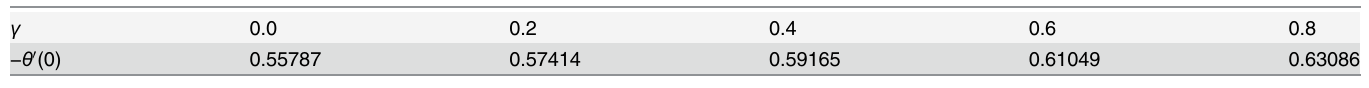
Table 4. Values of heat transfer rate at the surface − θ 0 (0) in elastico-viscous fluid when k (cid:3) 1 ¼ 0 : 2 and Pr = 1.0. γ